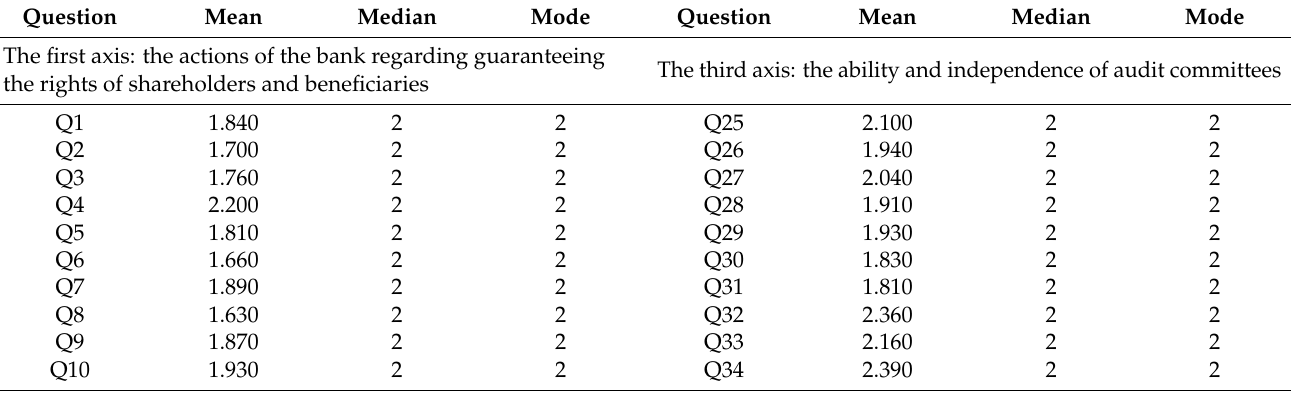
Table 3. The descriptive statistics of data related to corporate governance in Islamic banks in